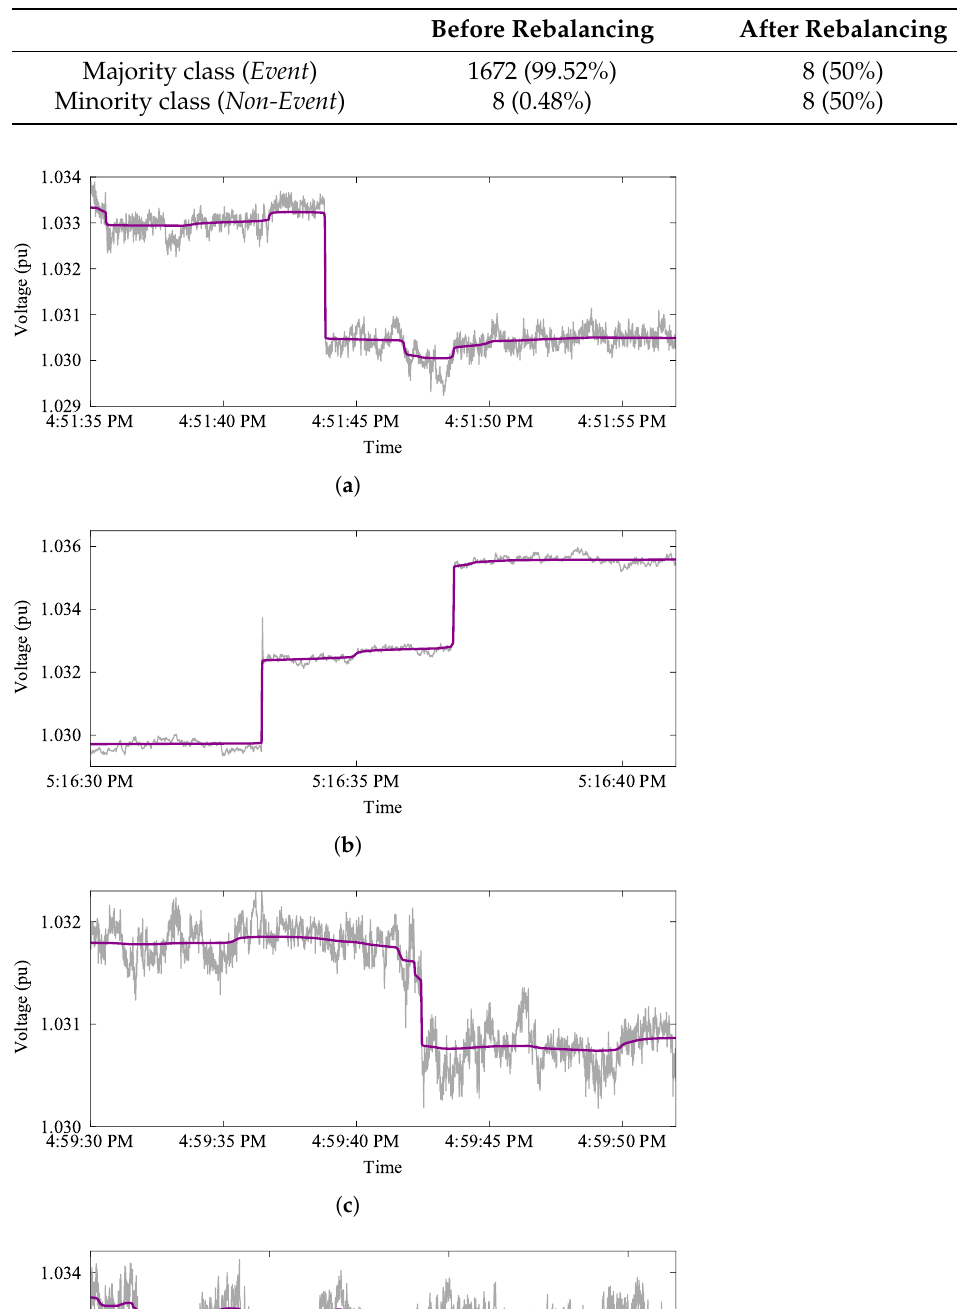
Table 1. Class distribution for the PQM dataset before and after rebalancing.